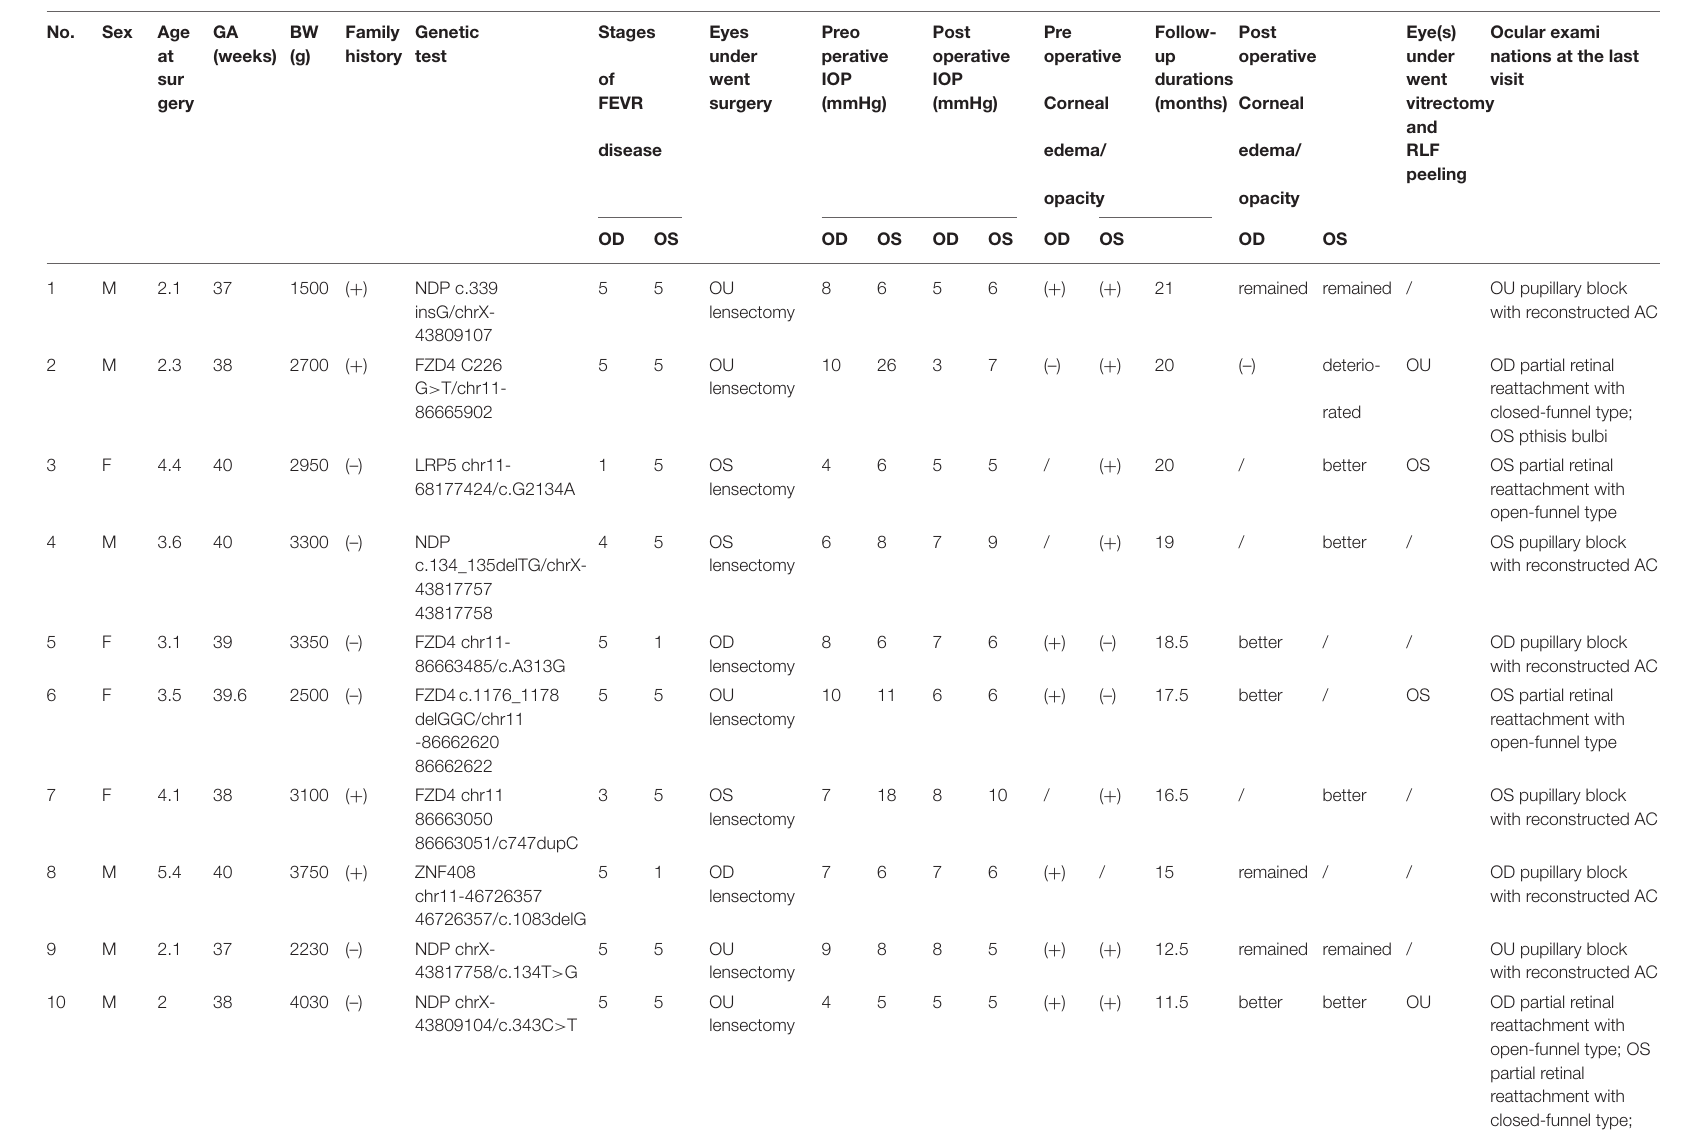
TABLE 1 | Clinical information of the patients. No. Sex Age at sur